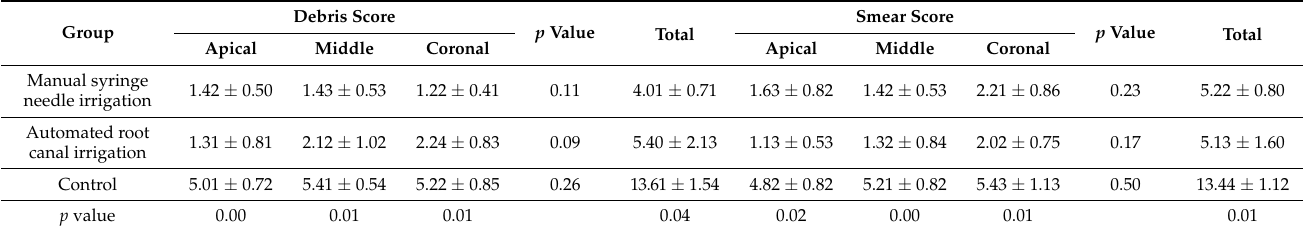
Table 3. Mean distribution of debris and smear scores among different groups.